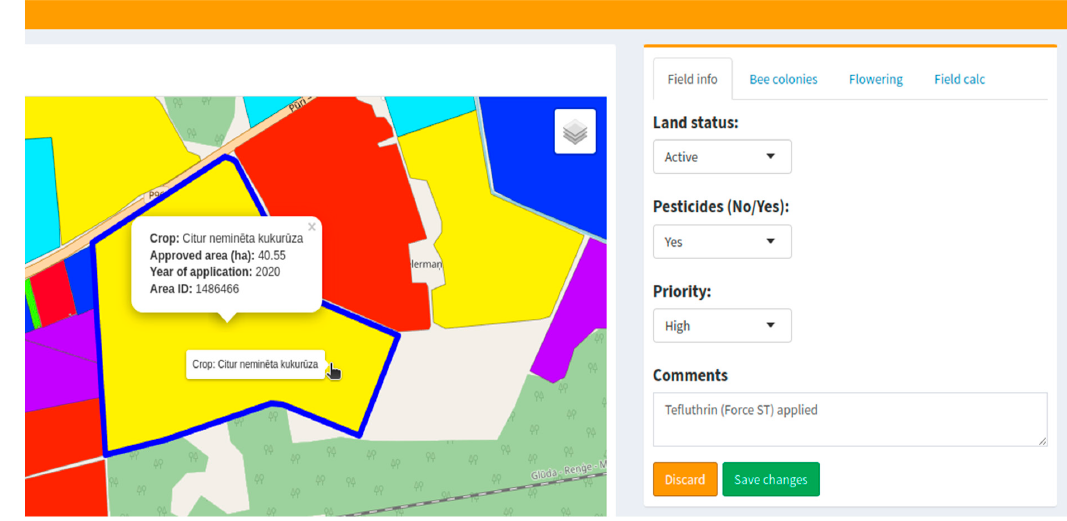
Figure 10. Edit mode of the field data. Different colors represent different crops.